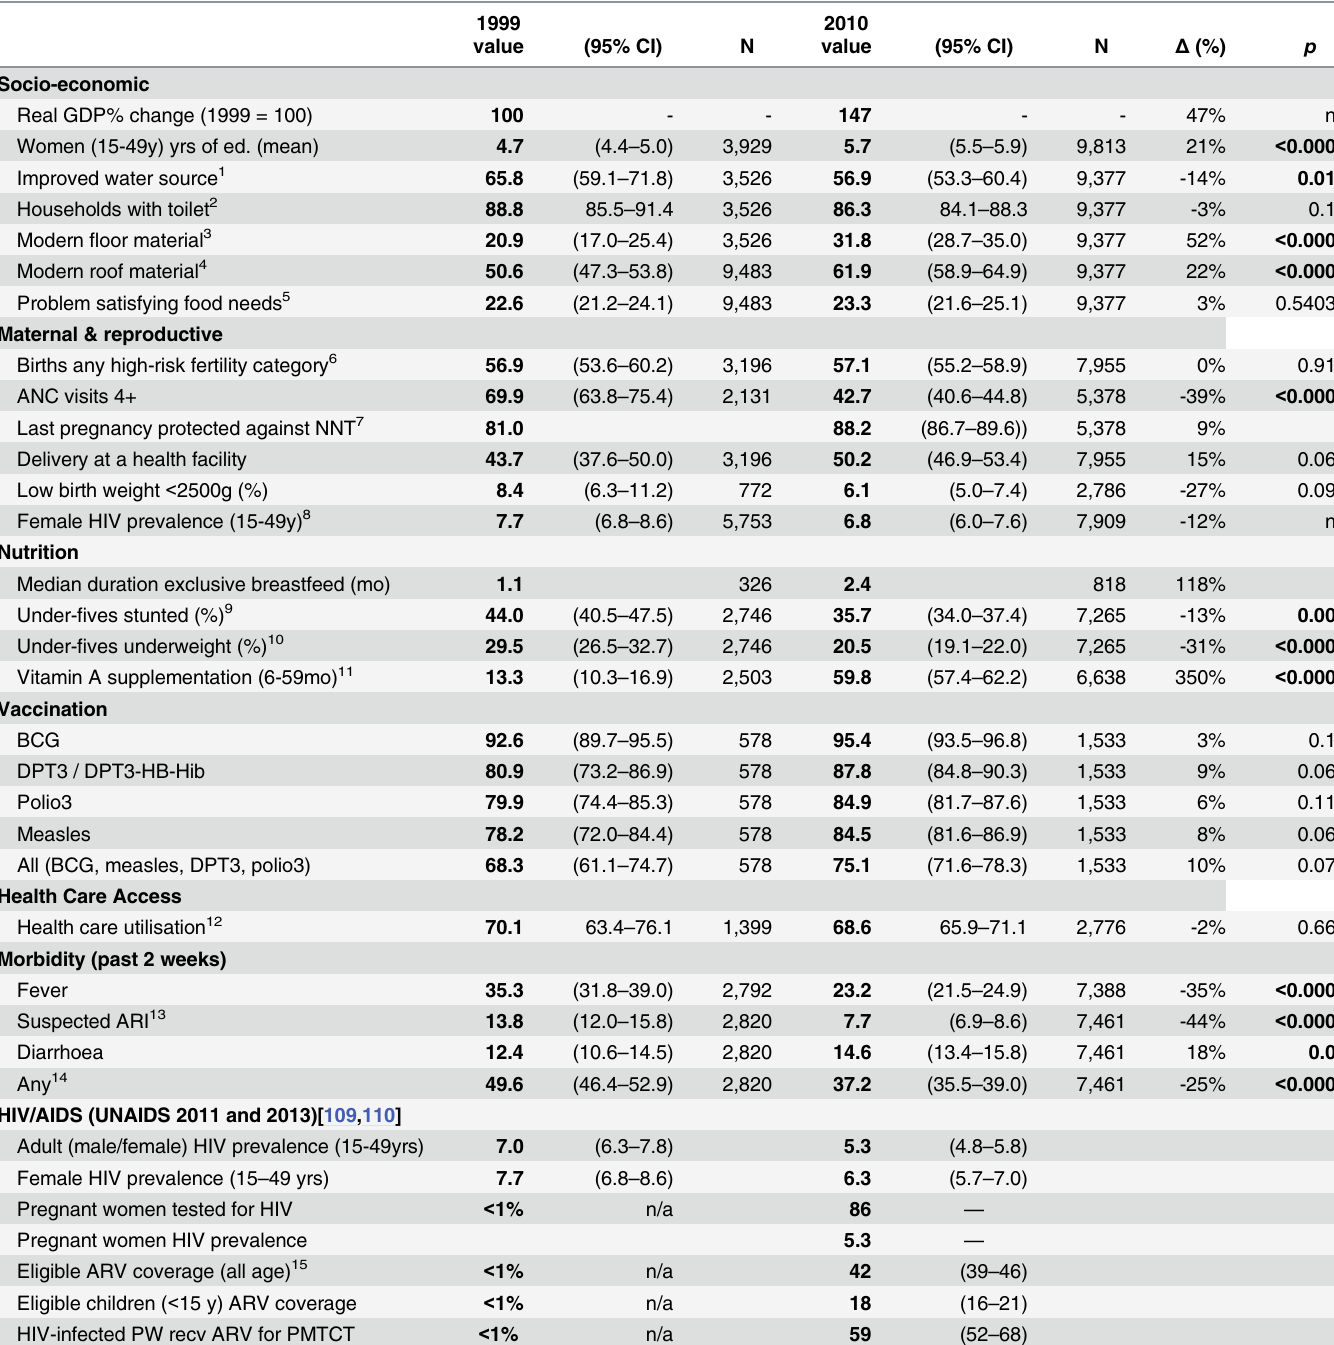
Table 4. Prevalence (%) of contextual variables recognized to influence all-cause mortality over time in Mainland Tanzania, 1999 versus